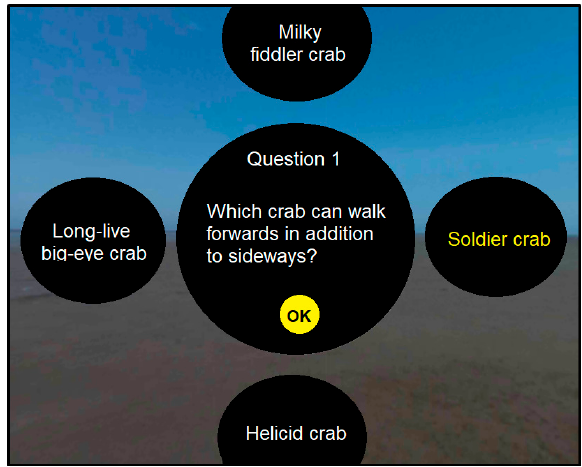
Figure 10. Answering a question in the challenge mission of Hsiang Shan wetland.